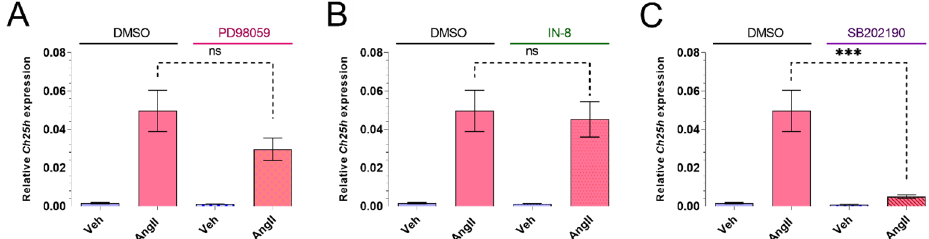
Figure 3. Effect of MAP kinase family inhibitors on Ch25h gene expression in rat VSMCs. ( A ) Serum- deprived VSMCs were treated with 20 μ M PD98059, ( B ) 1 μ M JNK-IN-8 (IN-8), or ( C ) 50 μ M SB202190 for 30 min. The negative control group was treated with DMSO for 30 min in each exper- iment. Following treatment, VSMCs were stimulated with 100 nM AngII or vehicle (Veh) for 1 h. Ch25h mRNA levels are shown relative to Gapdh . Values are plotted as the mean ± SEM of n = 6 independent experiments. Data were analyzed using multiple linear regression, *** p < 0.001, ns (not significant).